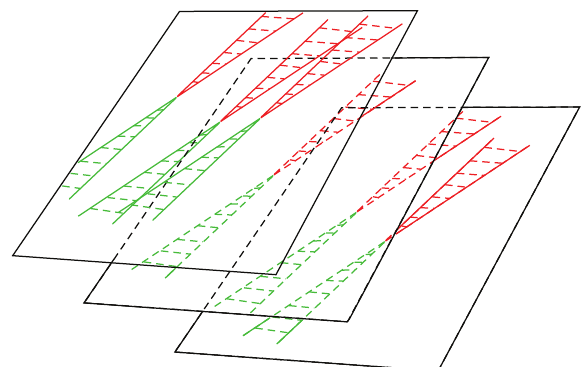
Figure 11: Cones with empty interior in a 3D domain that are not just a ray.